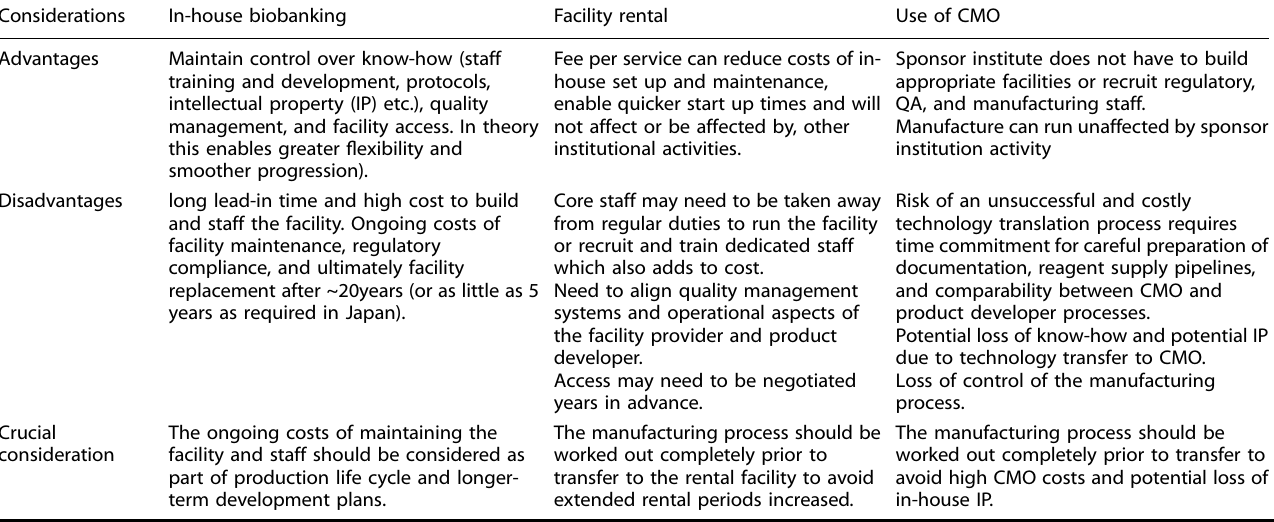
Table 2. A comparison of in-house banking, facility rental, and CMO options for hPSC biobanking and control of COGs. In-house